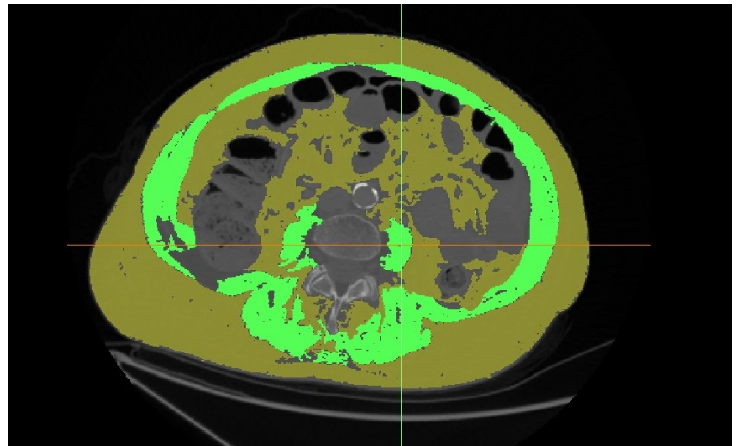
Figure 3. Sarcopenic obesity assessment.